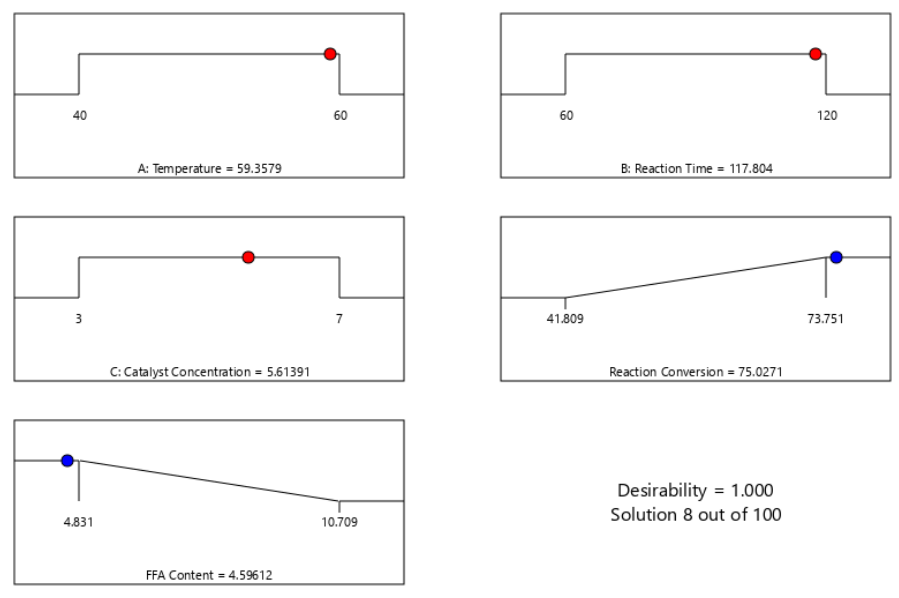
Figure 6. Optimization of Reaction Conversion and FFA Content using BBD Quadratic Model in RSM.